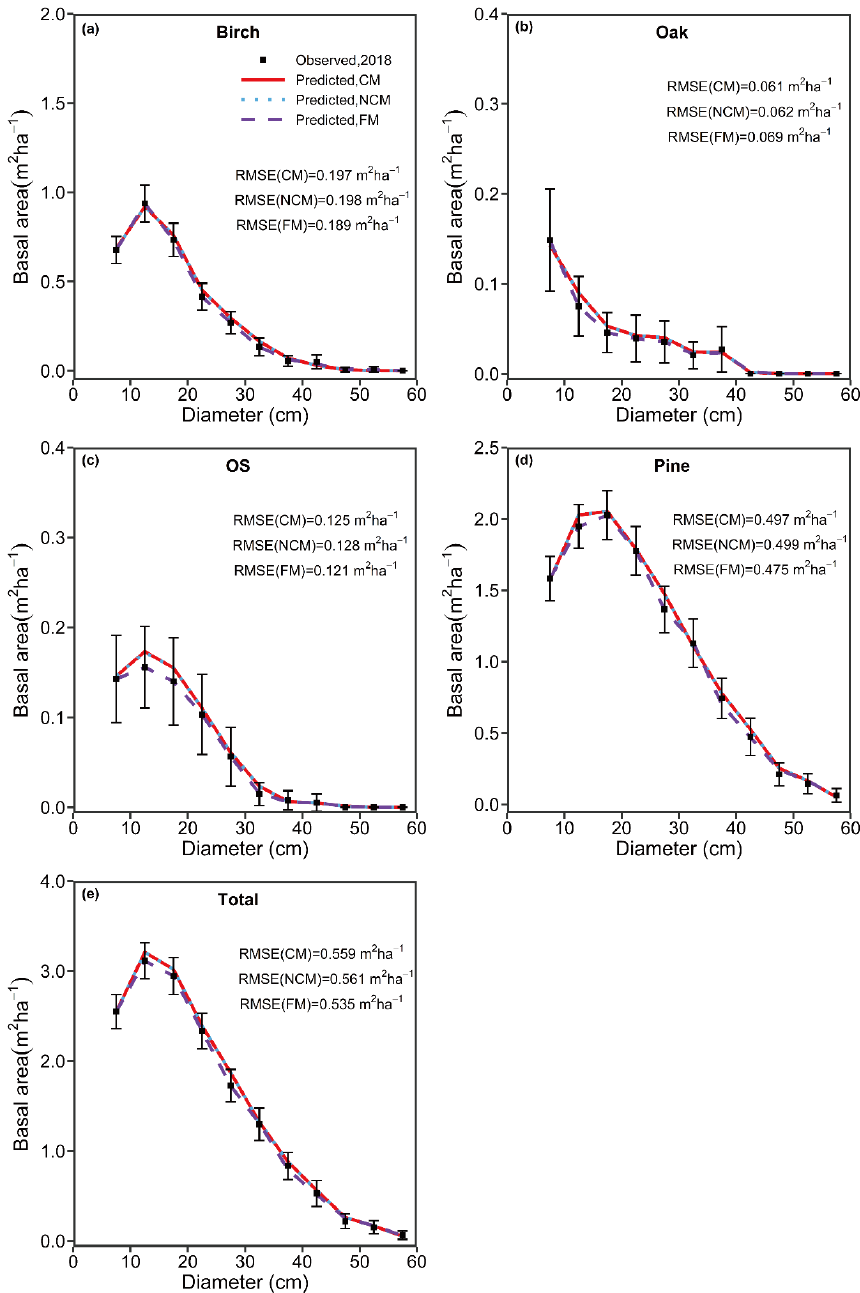
Figure 5. Average predicted and observed (with 95 % confidence intervals) basal area by diameter class and species group using the cross-validation technique, based on the first inventory of 428 sample plots.